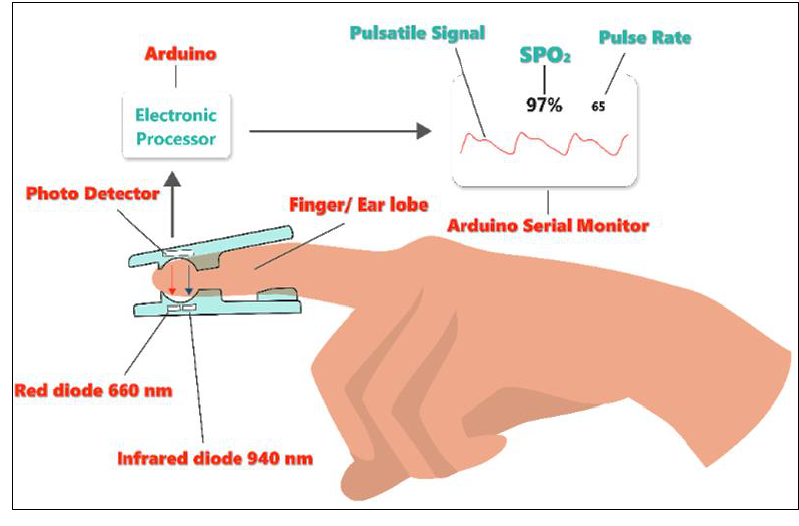
Figure 1. Pulse oximetry